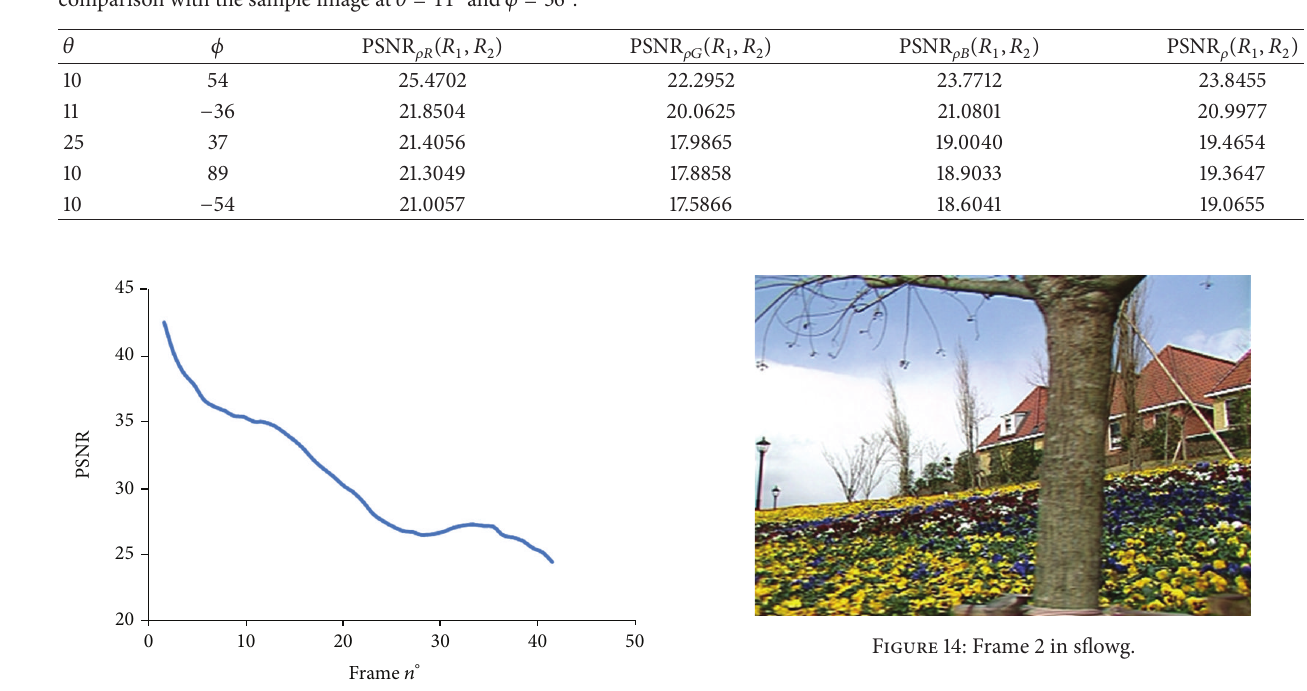
Table 2: Best PSNR from the F-transform based method with 𝐿 = 255 and 𝜌 = 0.006944 for the eraser image dataset obtained from the comparison with the sample image at 𝜃 = 11 ∘ and 𝜙 = 36 ∘ .